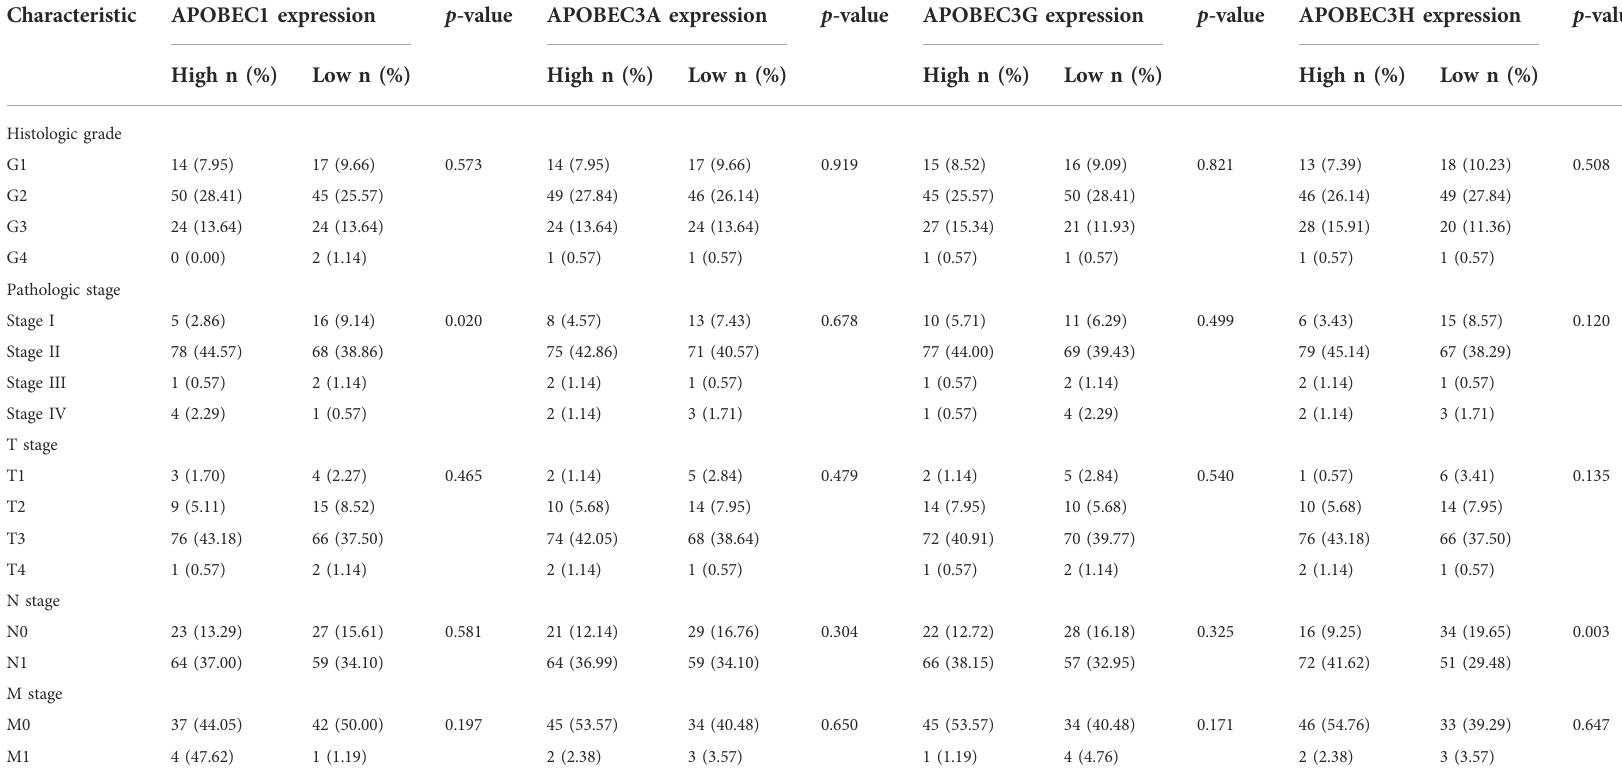
TABLE 1 Relationship between the APOBEC family members APOBEC1, APOBEC3A, APOBEC3G and APOBEC3H expression and clinicopathological characteristics of PAAD